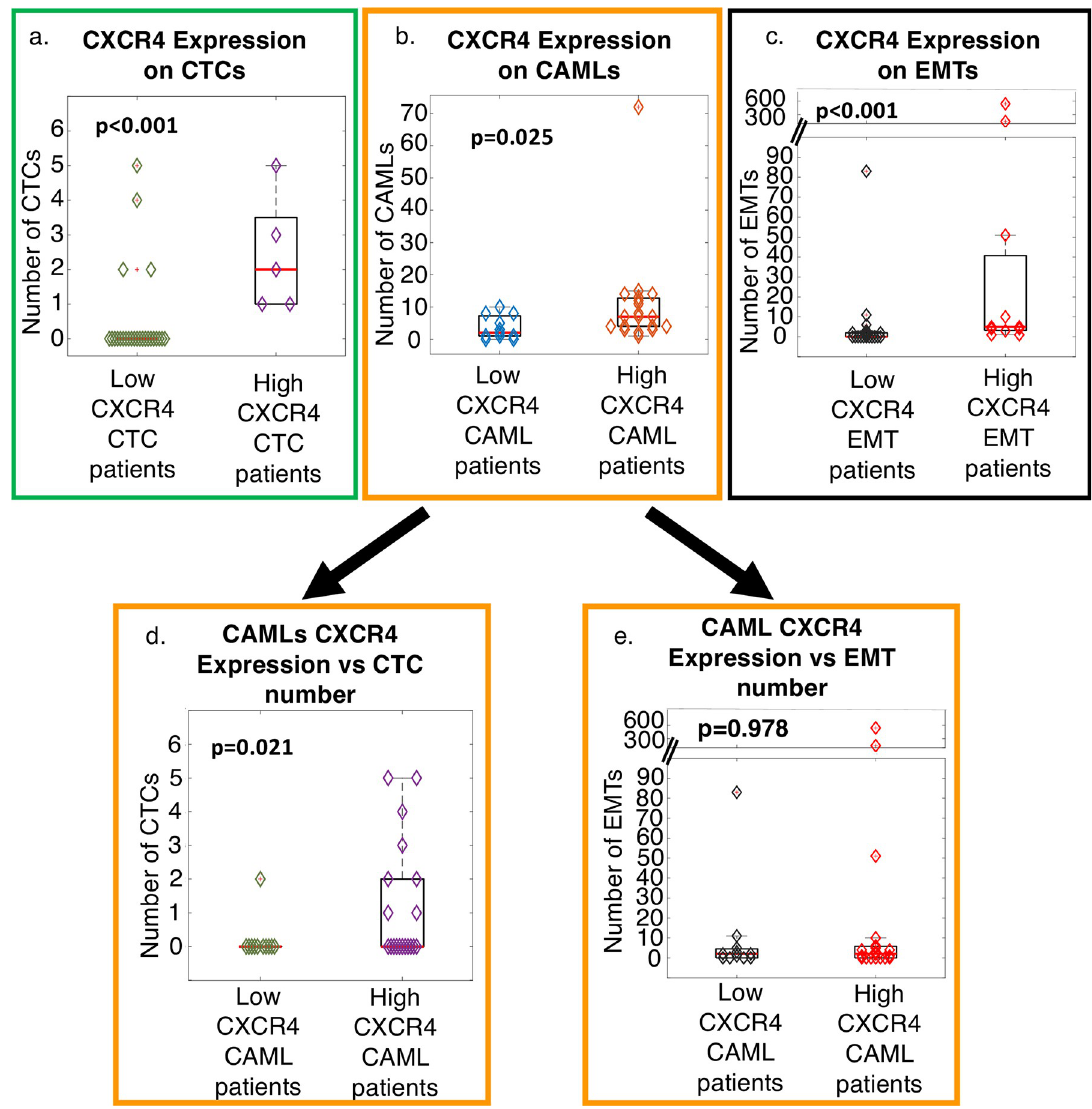
Fig 3. Relationship of CXCR4 expression and number of CTCs, CAMLs, and EMTs in circulation. a. Whisker Plots of patient’s CTC number based on high/low expression of CXCR4. Wilcoxon ranked sum (p < 0.001) b. Whisker Plots of patient’s CAML number based on high/low expression of CXCR4. Wilcoxon ranked sum (p = 0.025). c. Whisker Plots of patient’s EMT number based on high/low expression of CXCR4. Wilcoxon ranked sum (p < 0.001). d. Relationship of patient’s CTCs number based on expression of